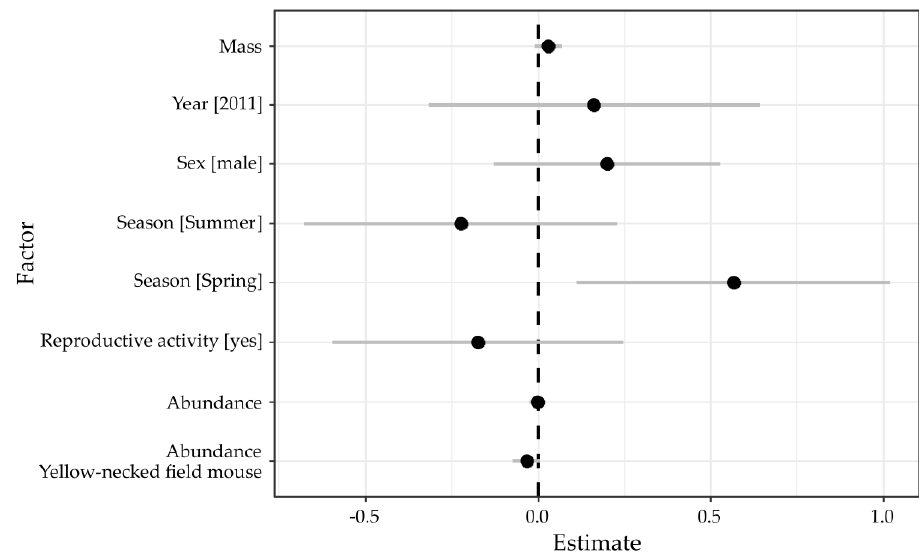
Figure 4. Graphical representation of the model averaging from all candidate models within an AIC of 2 of the best model (Models 1 to 14 in Table 4). Averaged mean estimates for all factors (black circle) and their 95% confidence interval (+/ − grey line) are presented on the x-axis. For categorical factors, the reference categories are female (Sex), autumn (Season), the year 2010 (Year), and reproductive inactivity (No). Here, a factor can be considered significant if the confidence intervals do not include zero (dashed line).